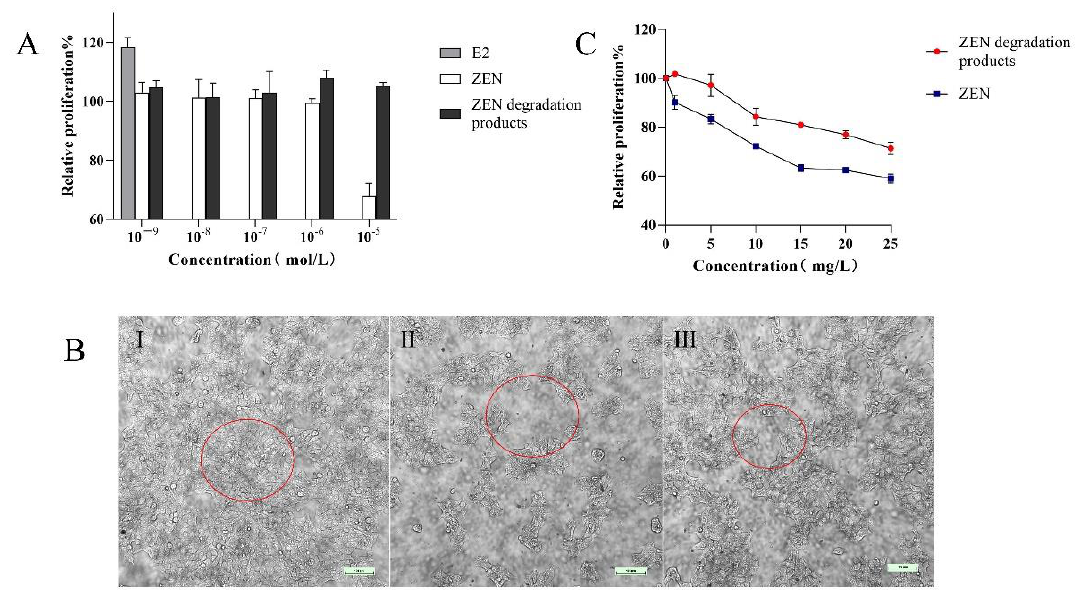
Figure 5. Estrogenic effects of E2, ZEN, and the degradation products of ZEN on the proliferation ( A ) and cell morphology ( B ) of MCF-7 cells (I: untreated MCF-7 cells; II: MCF-7 cells treated with 25 mg/L of ZEN; III: MCF-7 cells treated with 25 mg/L of ZEN degradation products). The toxic effect of substrate concentration of ZEN and the degradation products on the proliferation of MCF-7 cells ( C ).